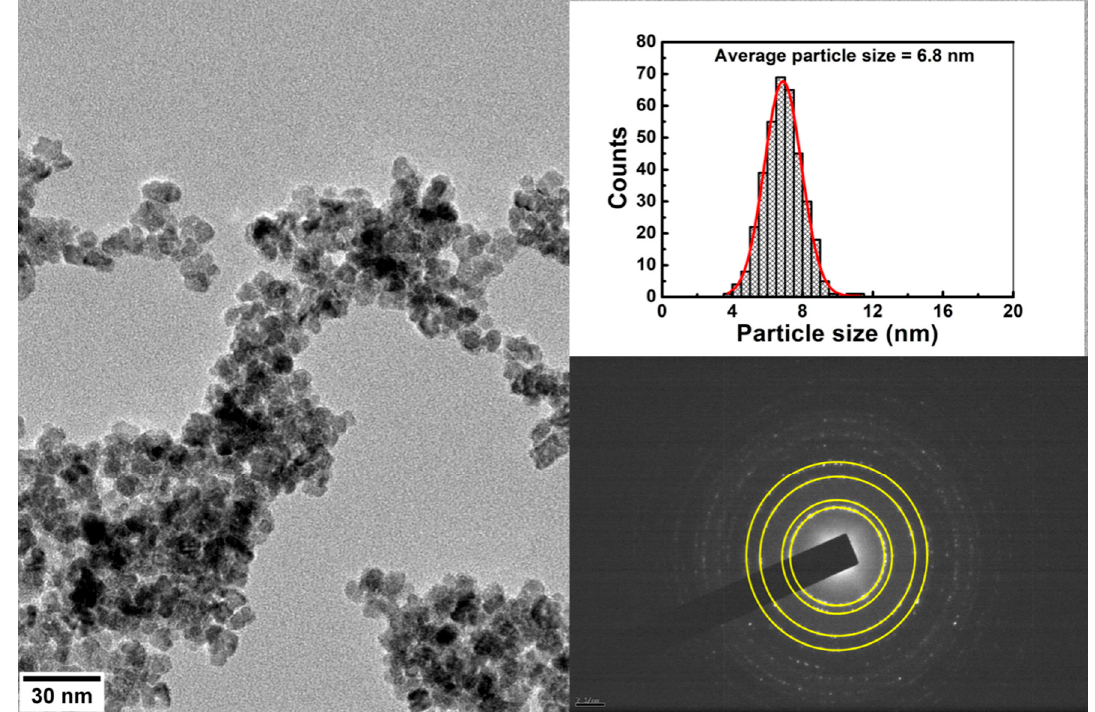
Figure 2. TEM micrograph of CeO 2 NPs. The upper inset shows the particle distribution histogram and the lower inset corresponding SAED patterns of CeO 2 NPs.